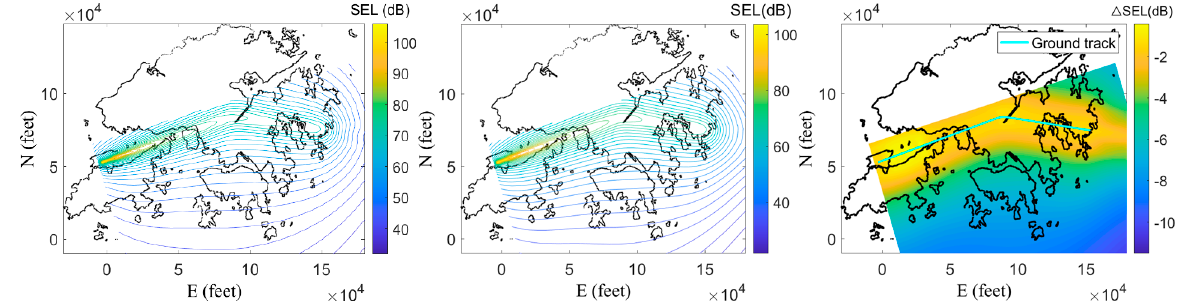
Figure 21. A330 and B777 aircraft noise impact (SEL) as recorded for various power settings (cor- rected thrust) and propagation distances. Excerpted from NPD database. Figure 22. B777 and (virtual) A330 aircraft approaching HKIA. Noise levels (SEL) generated by flight BA1 (left) and AA1 (center), along with their difference (obtained by subtracting the former from the latter, right).